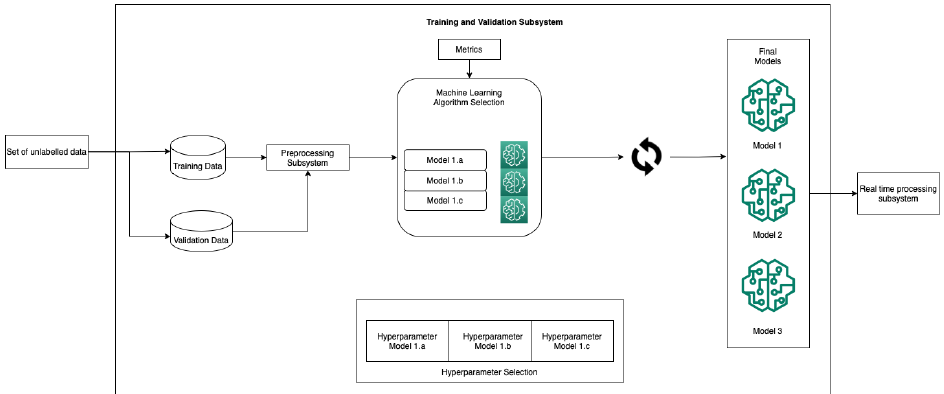
Figure 9. Modular architecture of the training and validation